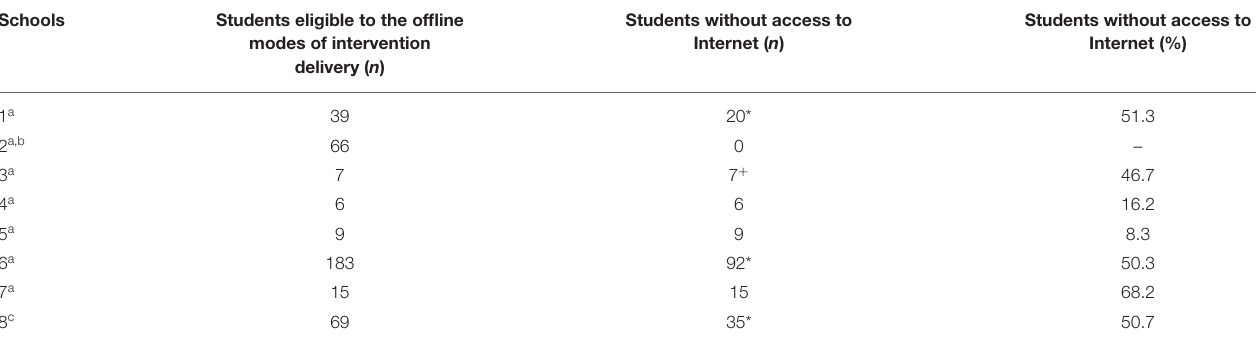
TABLE 4 | Estimation of children not reached if the offline modes of intervention delivery were not implemented (by school), based on the number of students without internet access.